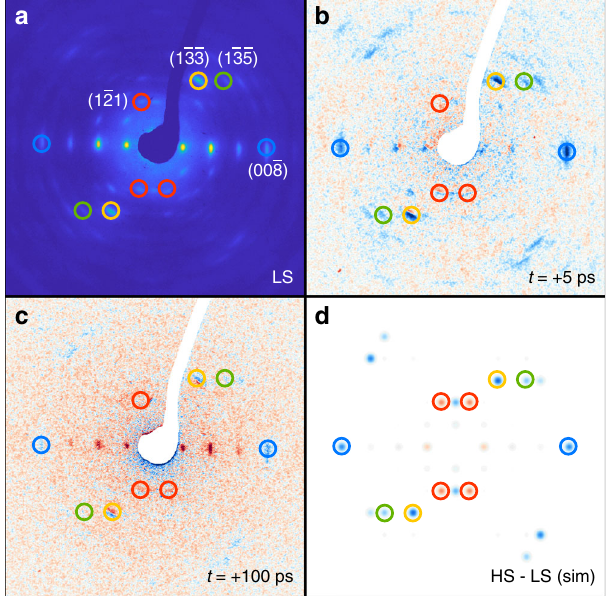
Fig. 2 Electron diffraction patterns. a Data measured at room temperature (T = 300 K) for the ground state low spin structure. b Signal induced by photoexcitation, measured after 5-ps time delay. c Signal induced by photoexcitation, measured after 100-ps time delay. d Difference between low spin ground state structure determined from X-ray diffraction and high spin structure from our calculation. The colored circles present several selected pairs of Bragg peaks. The positive changes in the intensity of Bragg spots is shown in blue, and the negative changes in the intensity of Bragg spots are shown in